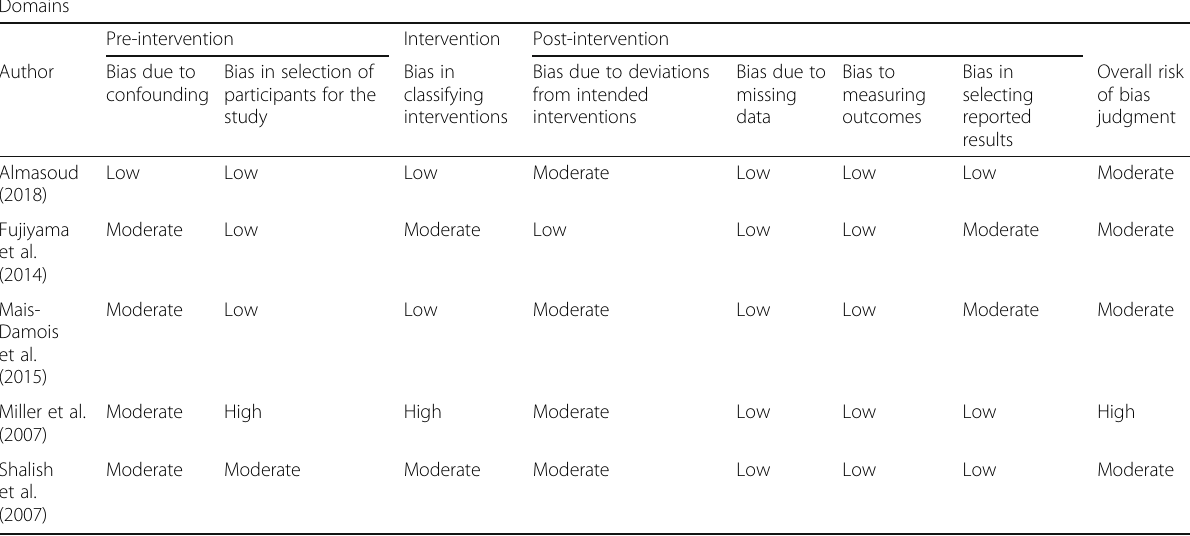
Table 6 Risk of bias of the included studies, according to the ROBINS-I